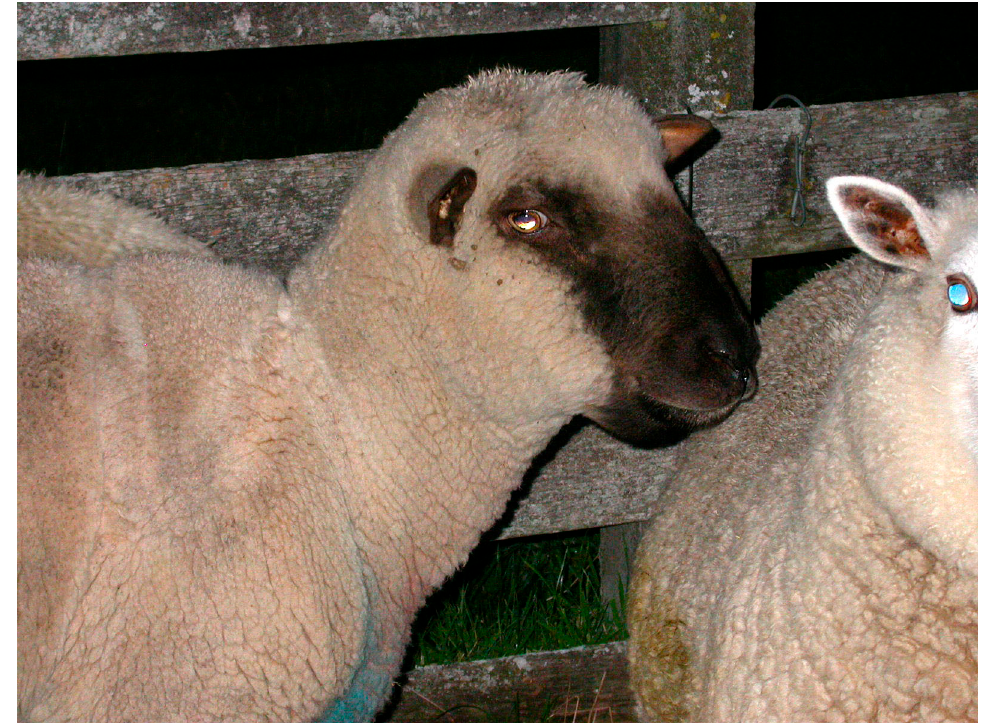
Figure 1. Oedema in the intermandibular space of a lamb (known as “bottle jaw”). Image courtesy of Professor K G Thompson, Massey University, New Zealand. Professor K G Thompson, Massey University, New Zealand